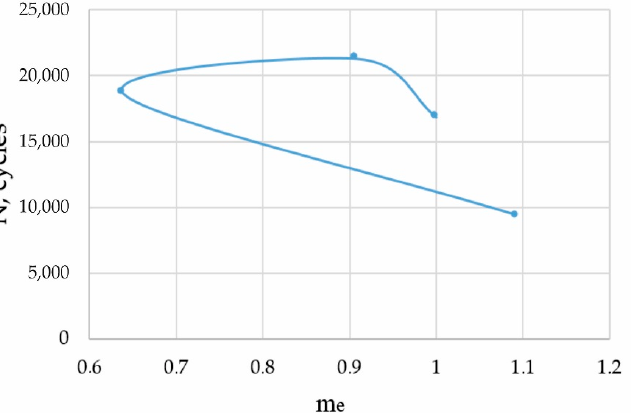
Figure 8. Dependence of cycles to fracture of alloy D16ChATW at different intensities of additional impulse loading applied ( ε imp = 3.7%, 5.4% and 7.7%) and in the initial state on the limiting values of m e (maximum cycle stress σ max = 400 MPa).